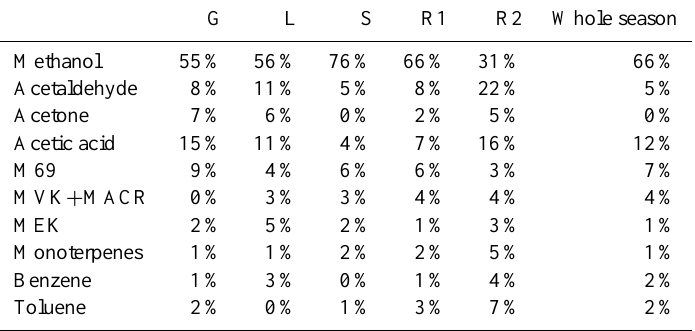
Table 3. BVOC composition per phenological stage. Each percentage corresponds to the ratio of the absolute mean flux of a particular compound during a phenological stage to the sum of the absolute mean fluxes of all investigated compounds during that stage. G L S R1 R2 Whole season Methanol 55% 56% 76% 66% 31% 66% Acetaldehyde 8% 11% 5% 8% 22% 5% Acetone 7% 6% 0% 0% Acetic acid 15% M69 9% 4% 6% 6% MVK + MACR 0%